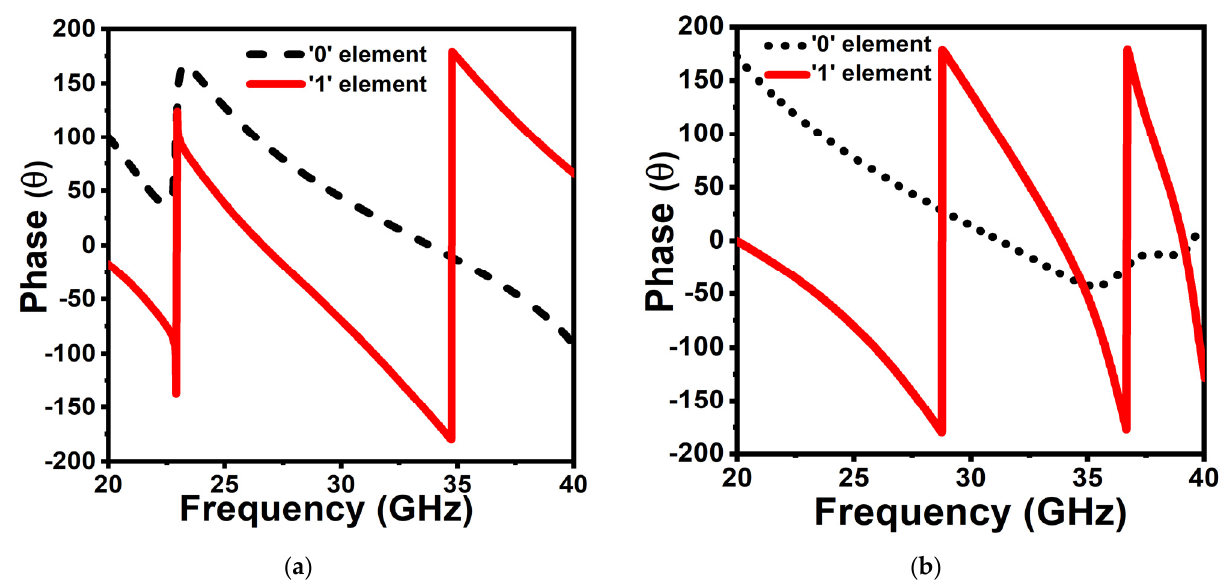
Figure 5. Reflection phase of two elements for ( a ) TE wave and ( b ) TM wave.